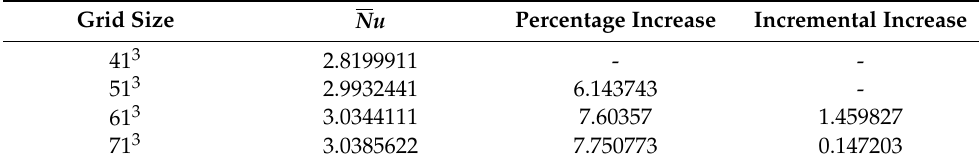
Table 2. Grid sensitivity test for reference case (a), N = 0 and Ra = 5 × 10 4 .